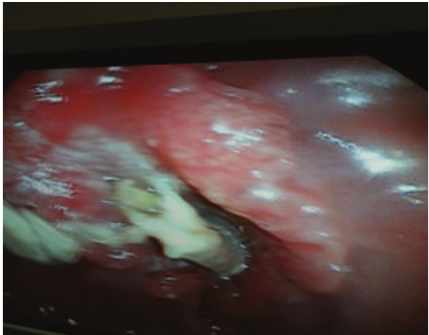
Figure 1: Upper endoscopy of patient showing an ulcerative lesion located between 25 and 38 cm of the